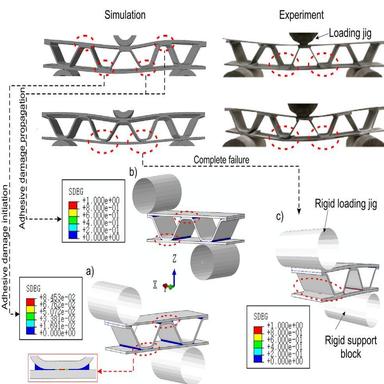
Deformation process of the ABCSS under three-point bending load of transverse loading direction, with adhesive a) damage initiation, b) damage propagation and c) complete failure modes.